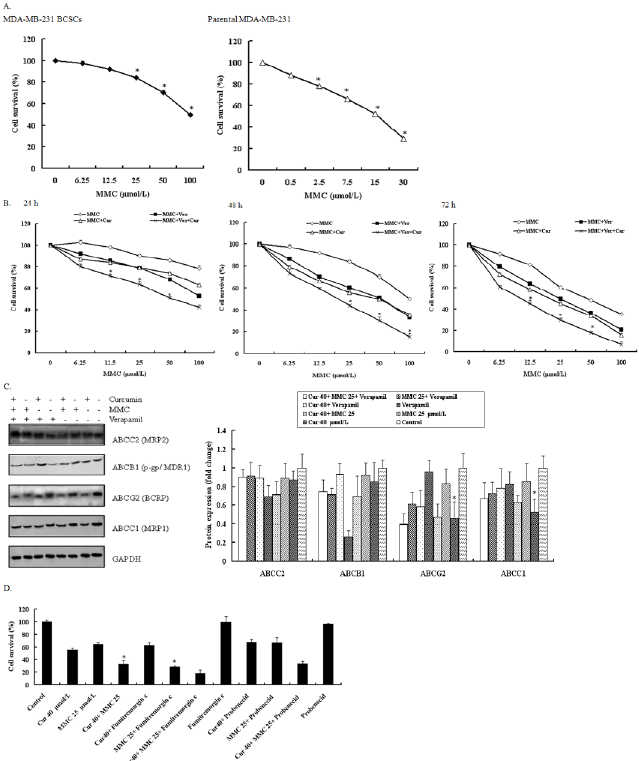
Fig 4. Effect of verapamil and curcumin on reversal of resistance to MMC in MDA-MB-231-derived BCSCs. (A) Cell survival was observed in MDA-MB-23-BCSCs and parental MDA-MB-231. Cells were treated with different concentrations for 48 h. * P < 0.05 compared with untreated control. (B) Dose- and time- dependent effect of MMC with and without verapamil and curcumin. * P < 0.05 compared with MMC and verapamil at corresponding doses. Cell survival was analyzed using MTT. Values are mean ± SD from 3 independent experiments. (C) Western blot analysis of ABCC2, ABCB1, ABCG2, and ABCC1 by curcumin and MMC with and without verapamil treatment in MDA-MB-231 BCSCs. Cells were incubated with 40 μ mol/ L curcumin, 25 μ mol/L MMC, 10 μ M/L verapamil and their combinations during 72 h. * P < 0.05 compared with MMC alone. (D) MDA-MB-231-derived BCSCs were treated with 40 μ mol/L curcumin and 25 μ mol/L MMC alone and together with and without fumitremorgin C and probenecid for 72 h. An MTT assay was performed. Values are mean ± SD from 3 independent experiments. * P < 0.05 compared with MMC